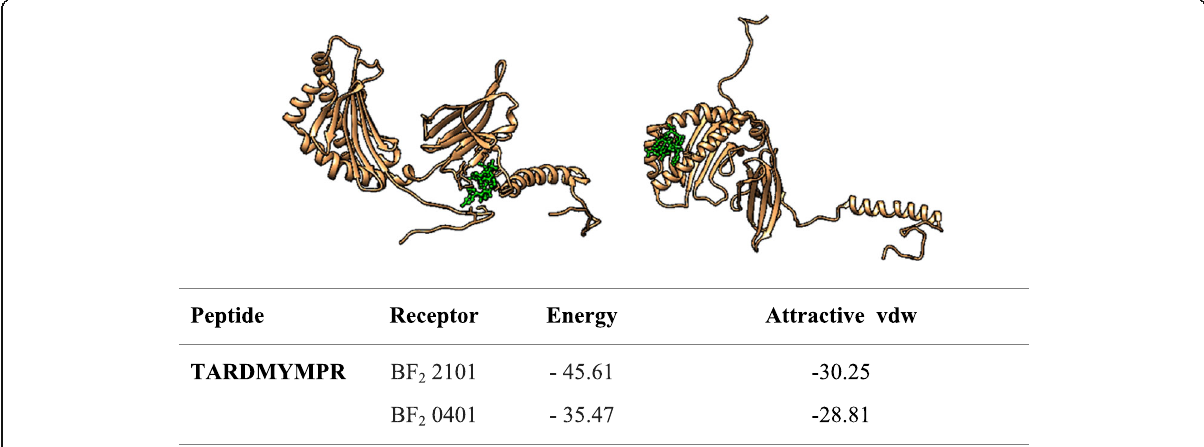
Fig. 9 Docking of TARDMYMPR with BF 2